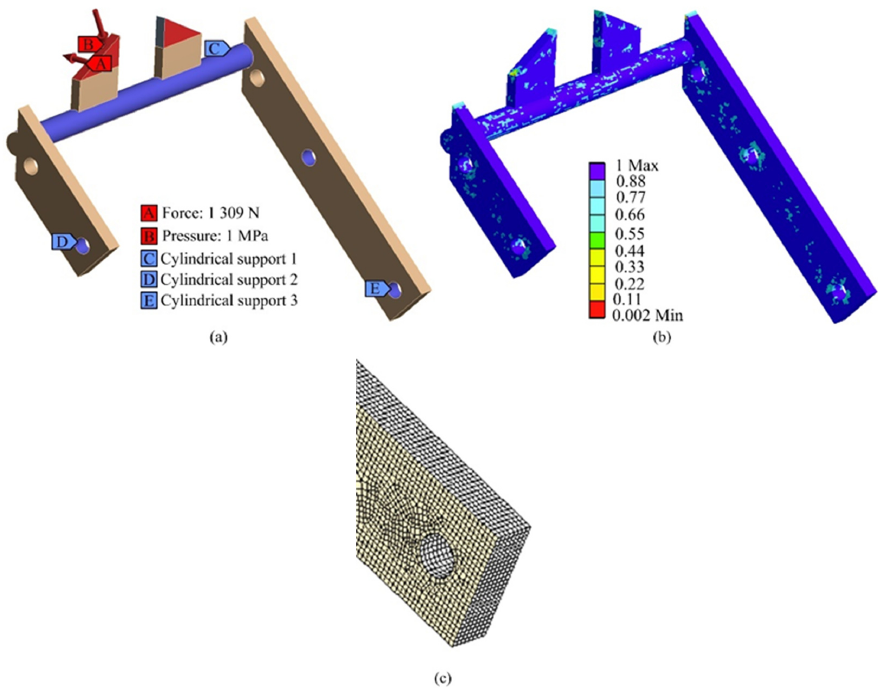
Figure 8. Model of the spike segment (actual design): ( a ) boundary conditions and loads applied, ( b ) Mesh quality, and ( c ) Detail of finite element mesh. ( b ) Mesh quality, and ( c ) Detail of finite element